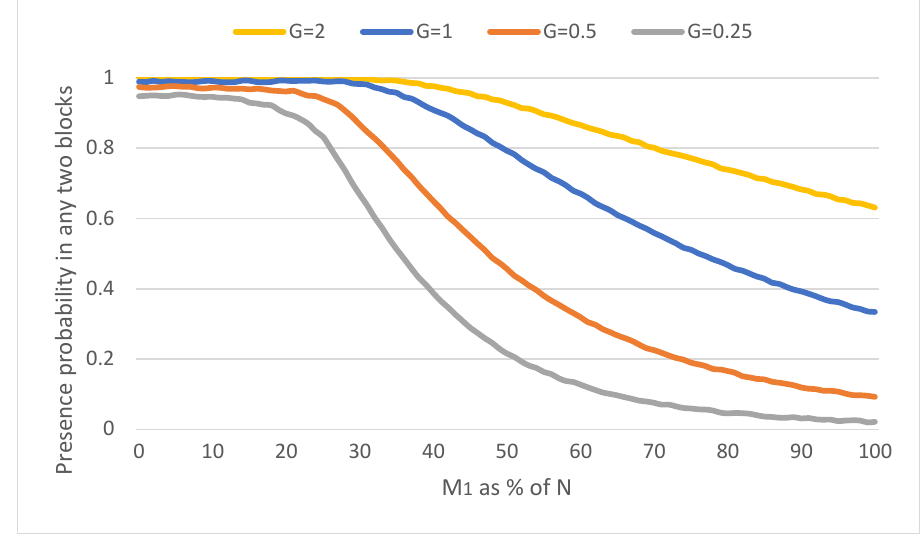
Figure 10. Presence probability of storing 𝑀 1 in next two blocks.